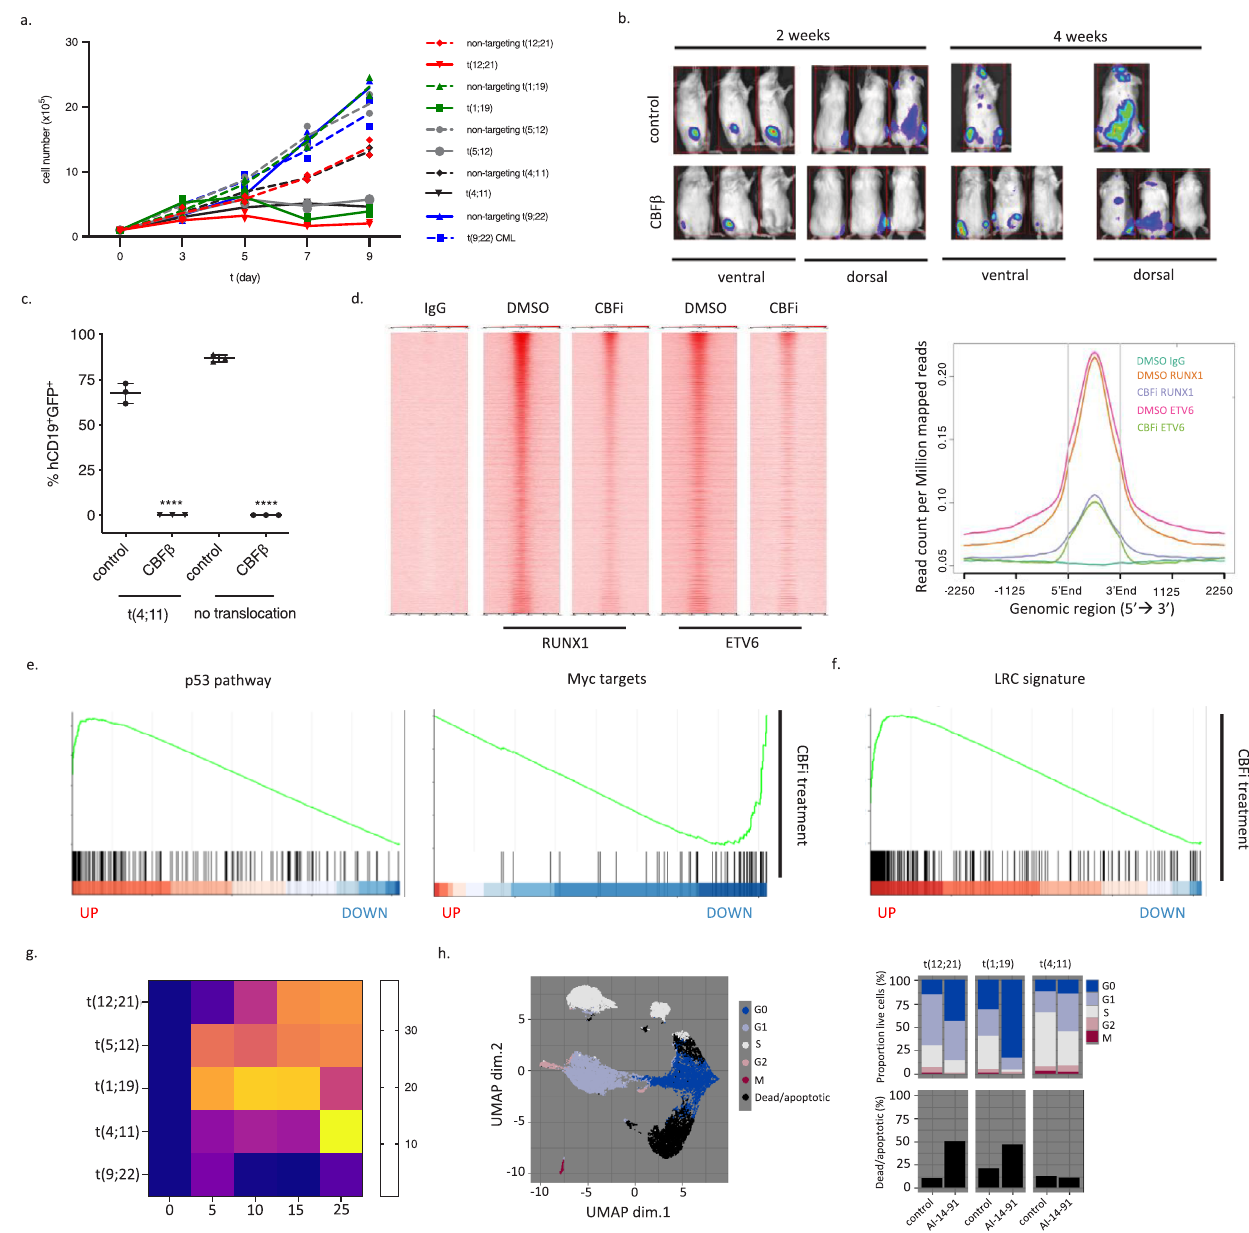
Fig. 8 | An allosteric CBF-inhibitor mimics RUNX1 depletion suggesting a tar- geted treatment for B-ALL. a Growth curves for the indicated cell lines following transductionwith CBFb -ornon-targeting shRNA.Datapresented asmean±SD, n = 3 biologically independent samples. b Ventral and dorsal bioluminescence, at weeks 2 and 4 (end point),of mice engrafted with shGFP + Luc + and competitor GFP − Luc − NALM-6 cells. Control: non-targeting shRNA; CBFb - CBFb -targeting shRNA. c Endpoint analysis of competitive engraftment (% GFP+ within human CD45+CD19+)ofindicatedpatientsamplestransducedwith CBFb -ornon-targeting shRNA. Data presented as mean ± SD, n = 3 biologically independent samples. d Heatmap and average pro fi les of ChIP-seq signal across RUNX1 and ETV6-RUNX1 binding sites in a 3kb window centered on peak summits from control (DMSO) or CBFi (AI-14-91) treated Reh following immunoprecipitation with RUNX1, ETV6 or control(IgG) antibodies.GSEAplotsfor indicatedHallmarkgene sets( e )and label- retainingcell(LRC)signature( f )againstgenesrankedfrommostsigni fi cantlyup-to mostsigni fi cantlydown-regulatedfollowingCBFbknockdown. g Heatmapshowing